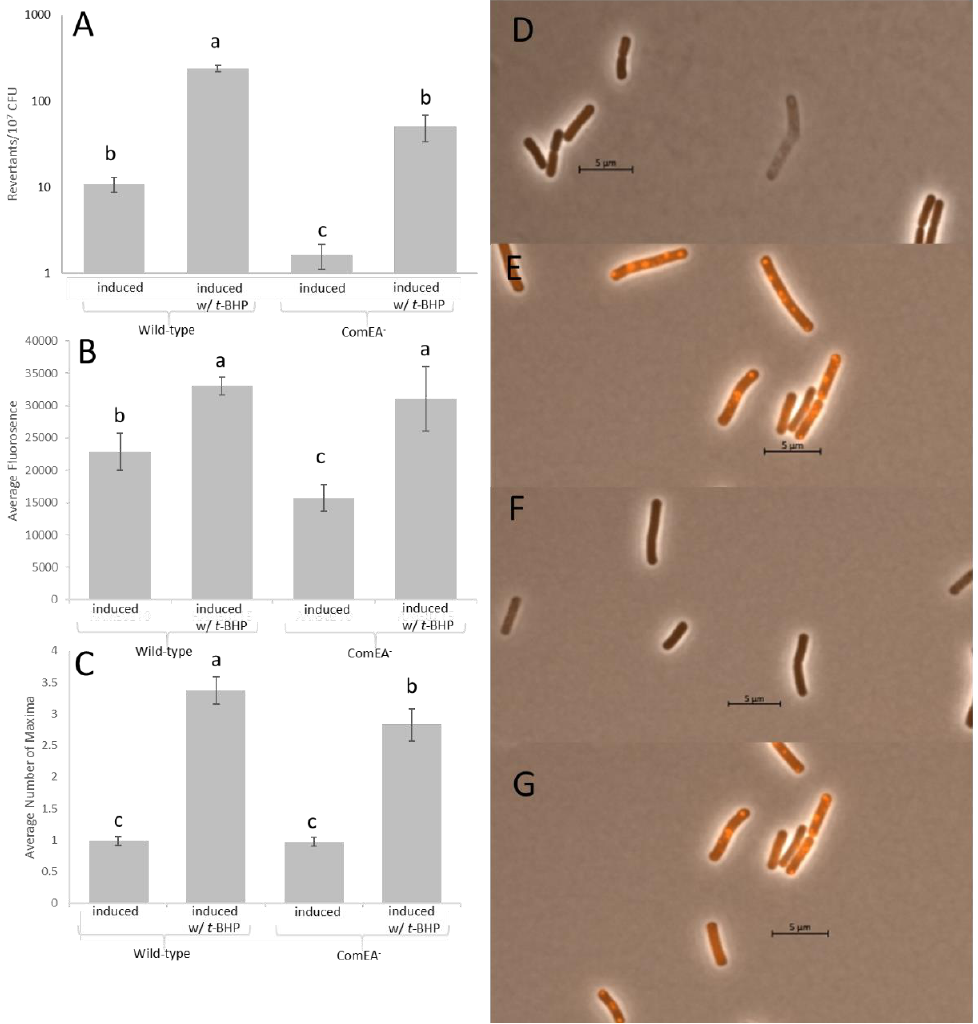
Figure 2. Stationary-phase mutagenesis and fluorescent microscopy with PO1. ( A ) The accumulation of stationary-phase revertants from days 5–9 in K-cells (HAM501) or K-cells lacking ComEA (AAK502) following treatment with either 0 or 1.5 mM t -BHP for two hours. ( B ) The average fluorescence within either induced or uninduced wild-type cells (HAM501) or cells lacking ComEA (AAK502) following treatment with either 0 or 5 mM t -BHP for two hours. ( C ) The average number of PO1 maxima within either induced or uninduced wild-type cells (HAM501) or cells lacking ComEA (AAK502) following treatment with either 0 or 5 mM t -BHP for two hours. ( D ) A representative image of induced wild-type cells (HAM501) following 0 mM t -BHP for two hours. ( E ) A representative image of induced wild-type cells (HAM501) following 5 mM t -BHP for two hours. ( F ) A representative image of induced cells lacking ComEA (AAK502) following 0 mM t -BHP for two hours. ( G ) A representative image of induced cells lacking ComEA (AAK502) following 5 mM t -BHP for two hours. Lower case letters were used to denote significant differences between means. “a”, “b”, and “c” are significantly different mean groups.